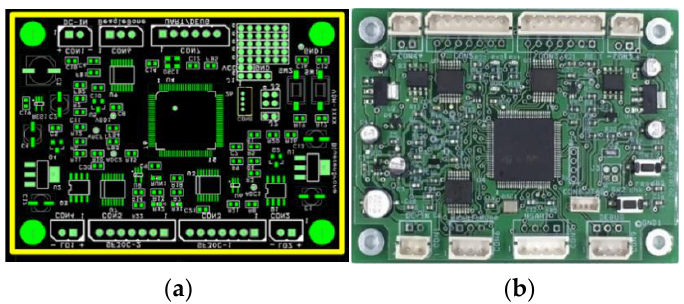
Figure 5. This is a VDM of the vehicle detection module part : ( a ) VDM hardware (H/W) artwork; ( b ) Developed VDM.